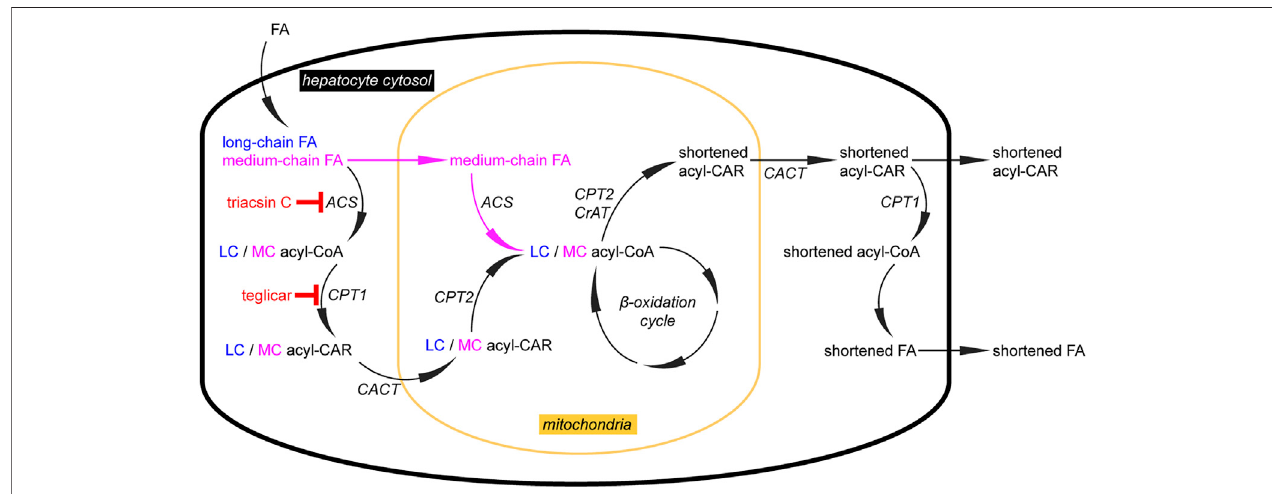
FIGURE 5 | Analysis of hepatic lipid catabolism with alkyne FA tracers. Using alkyne long-chain (LC) and medium-chain (MC) FAs, their different handling in the catabolic pathway of primary mouse hepatocytes was studied. Upon uptake, both FAs follow the pathway (left) with FA activation to an acyl-CoA, conversion to the corresponding acyl-CAR, transport into mitochondria, and regeneration of the acyl-CoA inside the mitochondria. These steps are governed by acyl-CoA synthetases (ACS), carnitine palmitoyltransferase 1 (CPT1), carnitine-acylcarnitine-translocase (CACT), and CPT2, respectively. When triacsin C or teglicar inhibit the cytosolic steps, only MCFAs can enter the mitochondria in the unesteri fi ed form, before activation by a mitochondrial ACS (that appears unaffected by triacsin C). In the mitochondrial matrix, these preparatory steps are followed by the actual β -oxidation cycle. This sequence of enzymatic reactions does not proceed completely successively for a single FA molecule but rather generates a pool of intermediates that is suf fi ciently long-lived to be accessible for CPT2 or carnitine acetyltransferase (CrAT) to generate shortened acyl-CARs that are released from the mitochondria to the cytosol (right). There, they undergo transesteri fi cation, forming acyl-CoA for various metabolic pathways, including secretion from cells. Of note, facilitated by an unidenti fi ed transporter, hepatocytes also secrete the shortened acyl-CARs. These metabolites may also ful fi ll a signaling function as they carry information about the metabolic status of this major β -oxidizing tissue, ref. (Kuerschner et al., 2022).